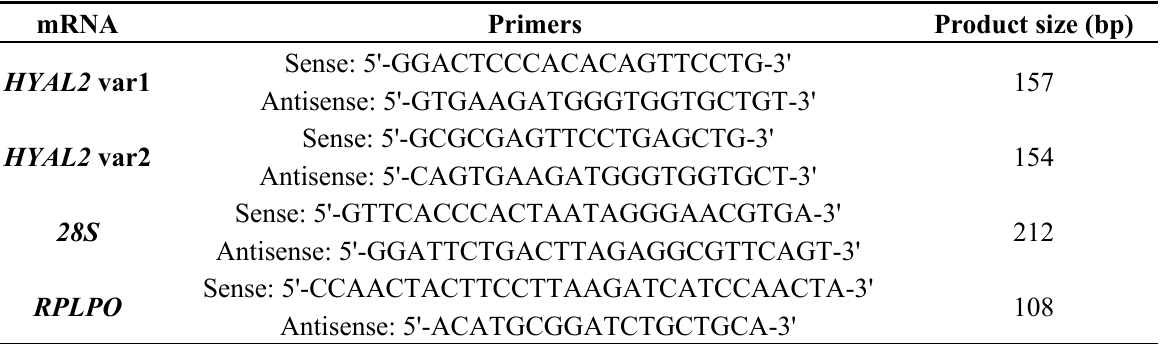
Table 5. Primers for quantitative PCR (qPCR).